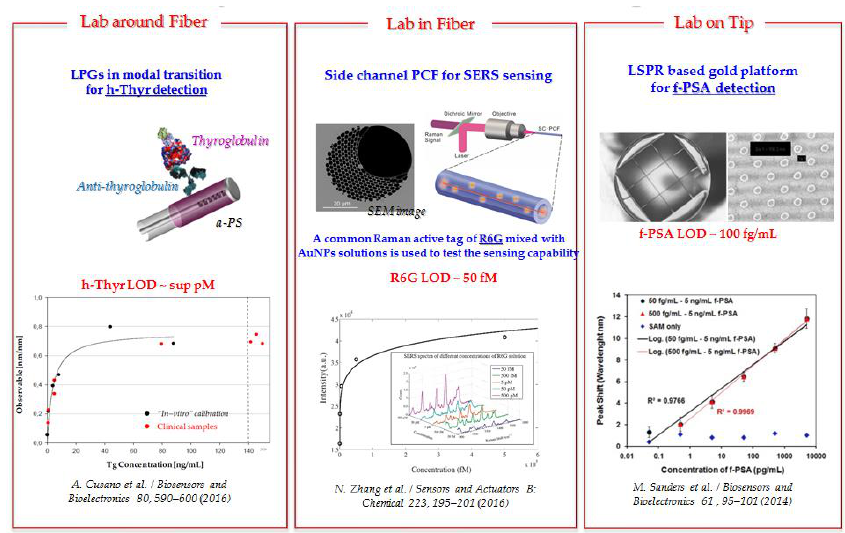
Figure 5. Representative results for LOF bioprobes with detection limits approaching the pM and fM regimes. Adapted with permission from [57] and [45]. Copyright © Elsevier B.V.